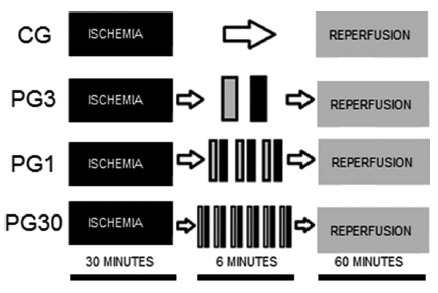
Diagram illustrating the post-conditioning protocols